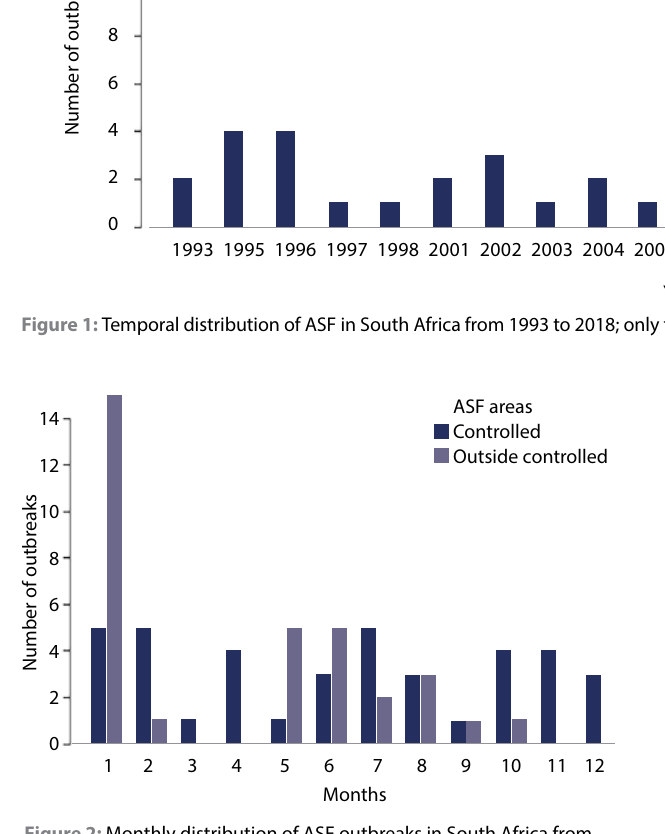
Figure 2: Monthly distribution of ASF outbreaks in South Africa from 1993 to 2018